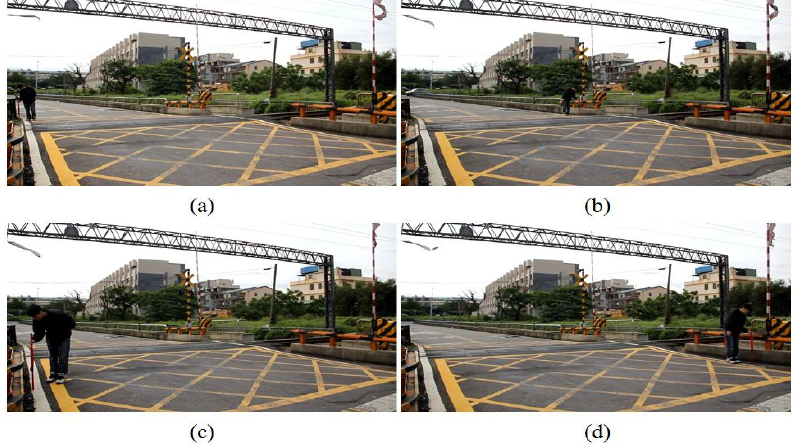
Figure 13. The terrain drop compensation measure of the railway crossing of the Doudile Road: ( a ) the rear-left corner; ( b ) the rear-right corner; ( c ) the front-left corner; ( d ) the front-right corner.